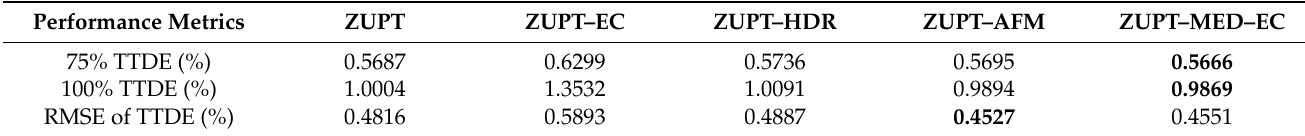
Table 5. Performance of the different frameworks on indoor dataset 1. Each bold number refers to the optimal performance in each row.